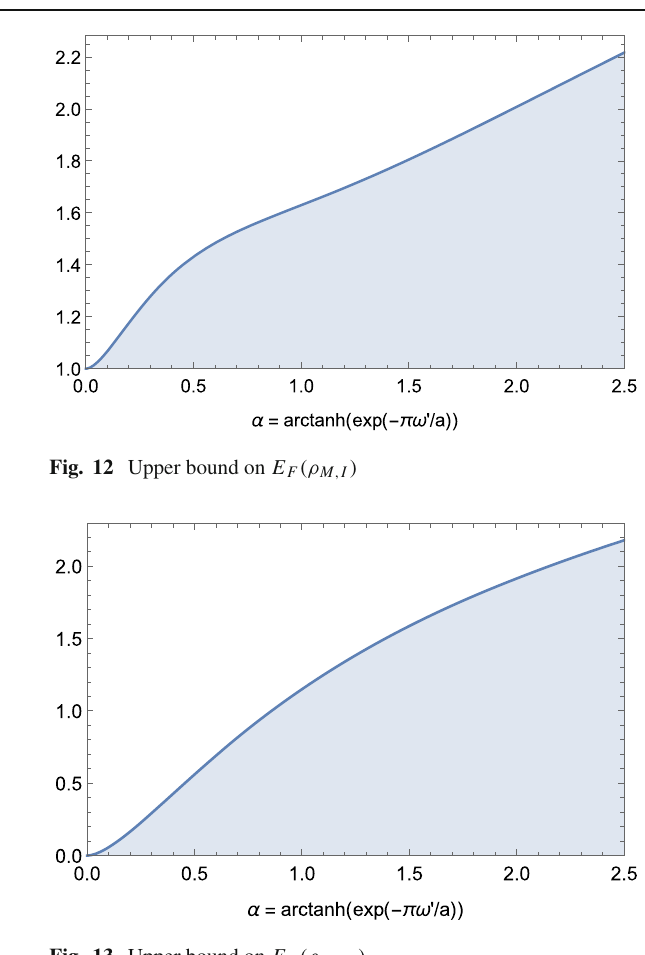
Fig. 11 Bounds on D → (ρ I , II )